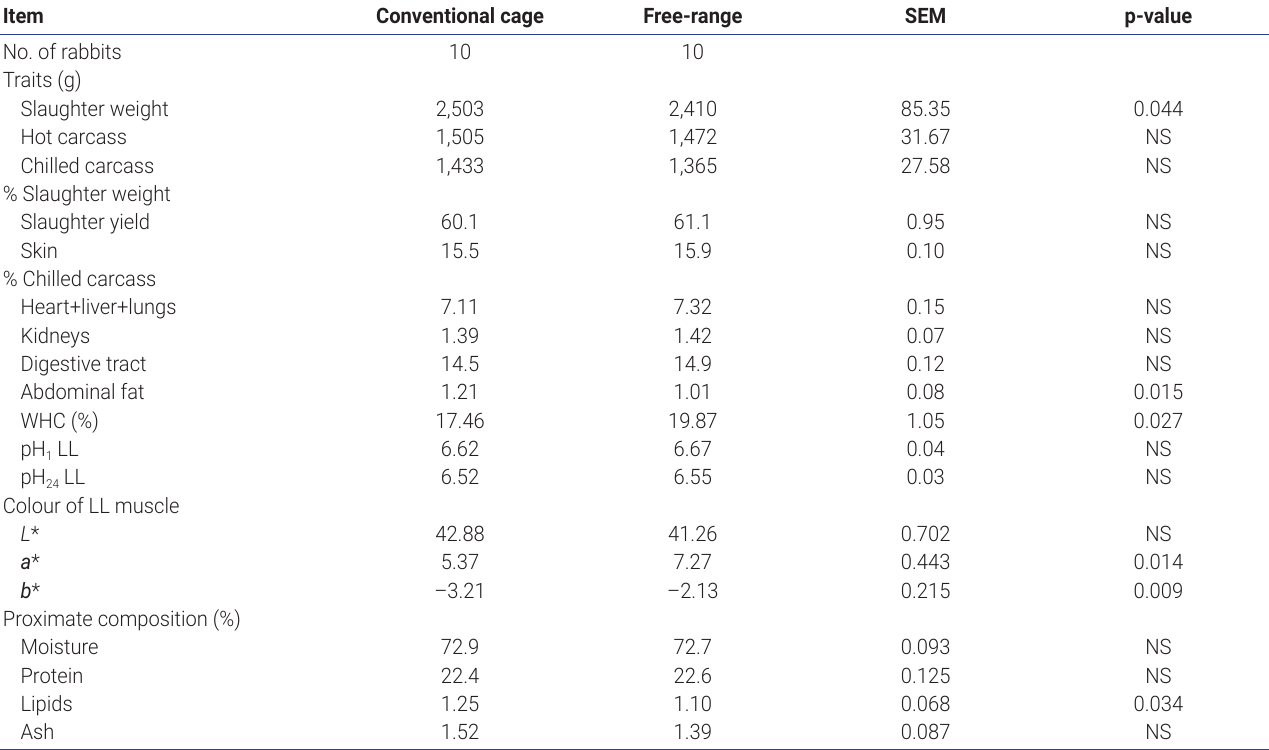
Table 3. Effect of rearing system on carcass traits, colour and proximate composition of meat muscle (Longissimus lumborum, LL) of rabbits Item Conventional